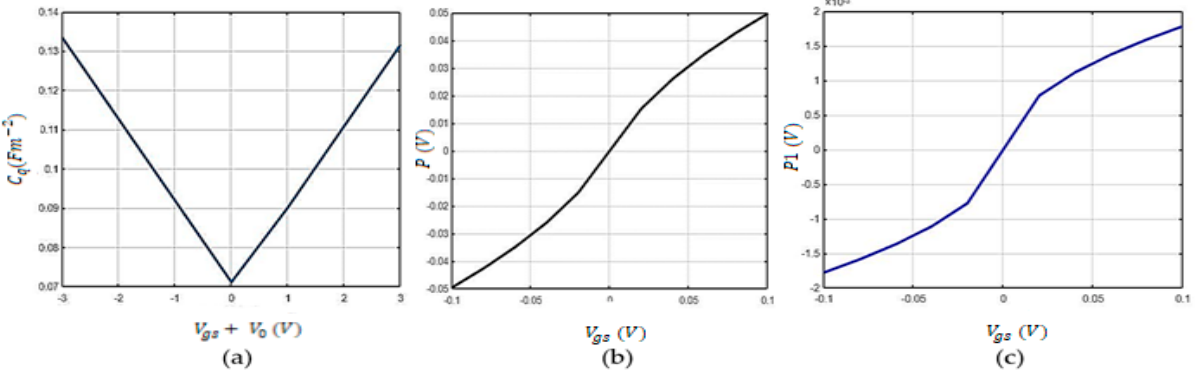
Figure 4. Graphical representation of gate-to-source voltage with quantum capacitance and surface potential as: ( a ) quantum capacitance as a function of top-gate-to-source voltage and ( b ) surface potential P (V) vs. top-gate-to-source voltage of a graphene field effect transistor (FET) from equation of surface potential [21]. ( c ) Surface potential P1 (V) vs. top-gate-to- source voltage V gs (V) from Laitinen equation of Fermi level shift [28].